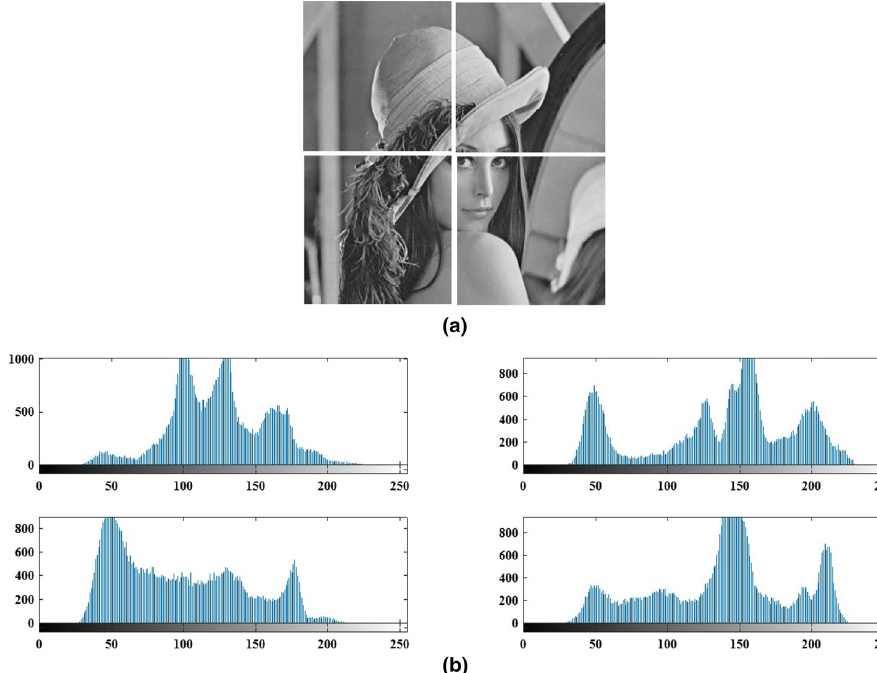
Fig. 2 a Block division of “Lena”; b Histogram of image “Lena” for each